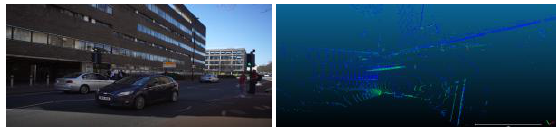
Figure 10. Study area for vehicle detection.